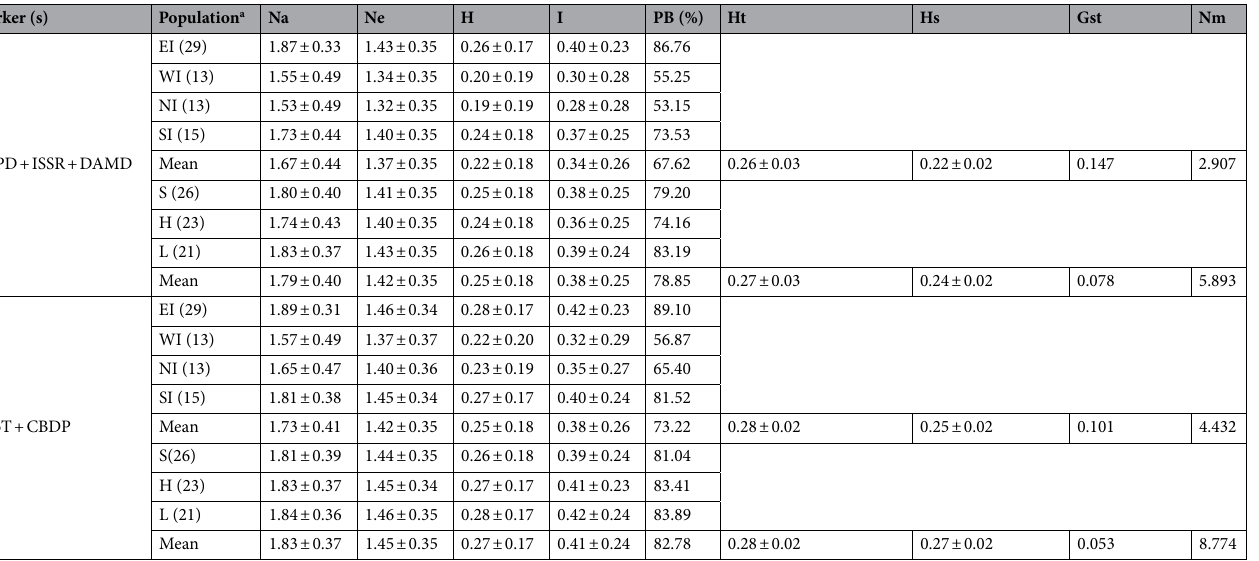
Table 3. Mean genetic variability statistics among 4 Geographical Populations (East India, West India, North India, South India) and 3 Fruit Status Populations (S = Selection, H = Hybrid and L = Landrace) of selected Indian mangoes based on individual and cumulative DNA marker analysis. Na observed number of alleles, Ne effective number of alleles, H Nei’s genetic diversity, I Shannon’s information index, NPB number of polymorphic bands, PB (%): polymorphic band percentage, Ht total genetic diversity, Hs genetic diversity within population, Gst coefficient of genetic differentiation, Nm Gene flow. a The numbers in parenthesis in each population denote the number of genotypes from that population used in the present